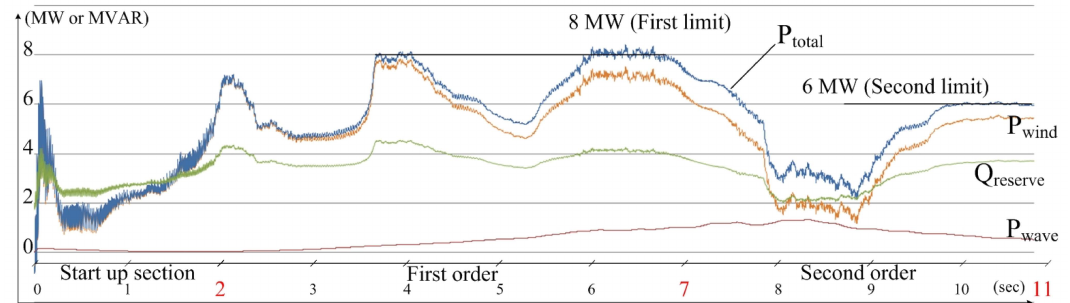
Figure 11. Output power and available reactive power curve of the HGS with previous control method (Case 2).